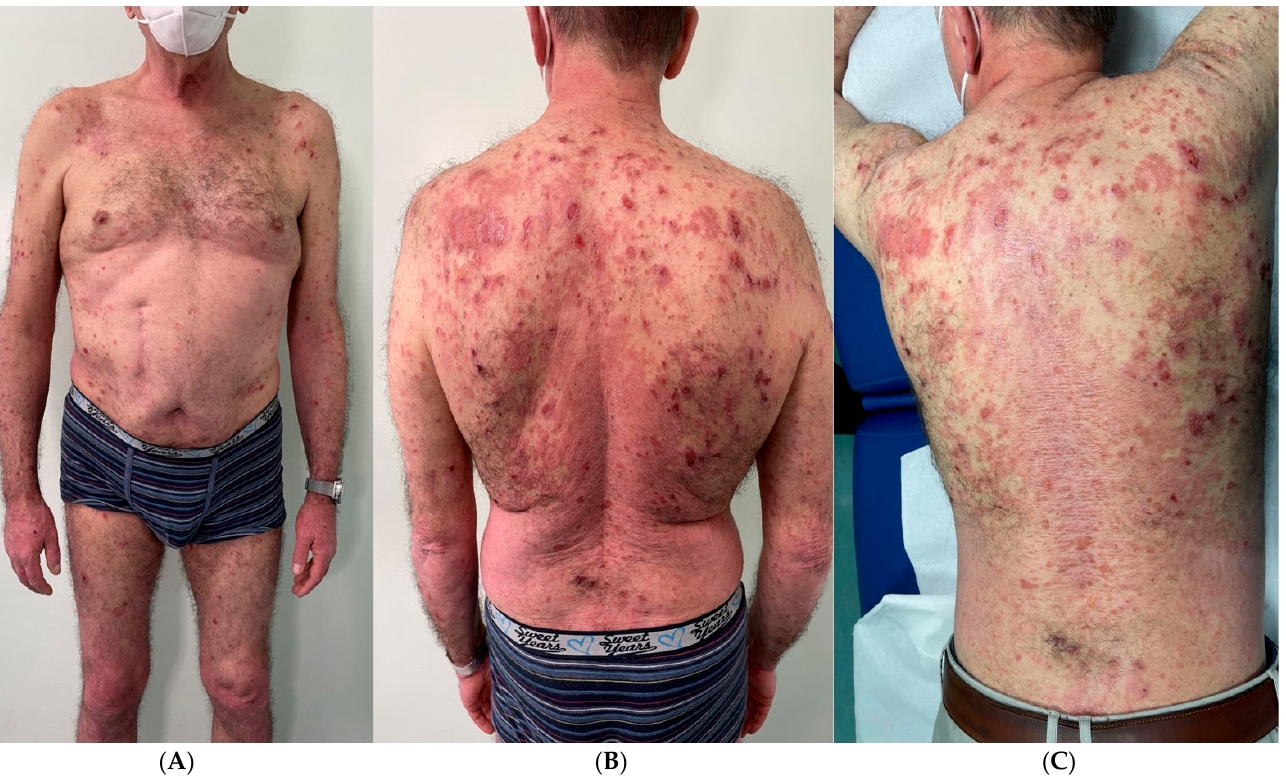
Figure 1. ( A – C ) Severe psoriasis worsening was experienced, with plaques involving the entire dorsal region and extending to the upper and lower limbs (PASI 15.2 and BSA 24%). Numerous bulla appeared at the scapular and clavicular regions, as well as at the upper and lower limbs.